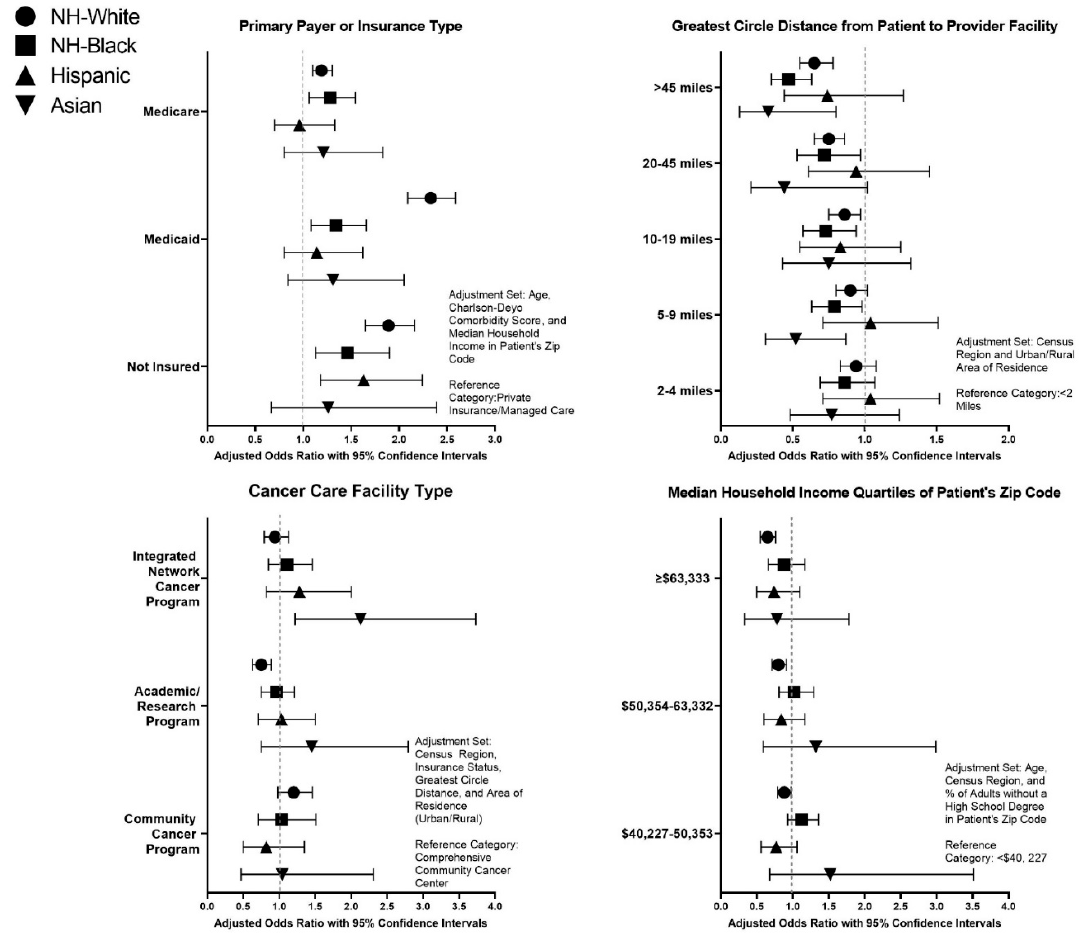
Figure 1. Associations of Health Care Access Measures with Palliative Care Use Among Metastatic Gynecological Cancer Patients by Race/Ethnicity.